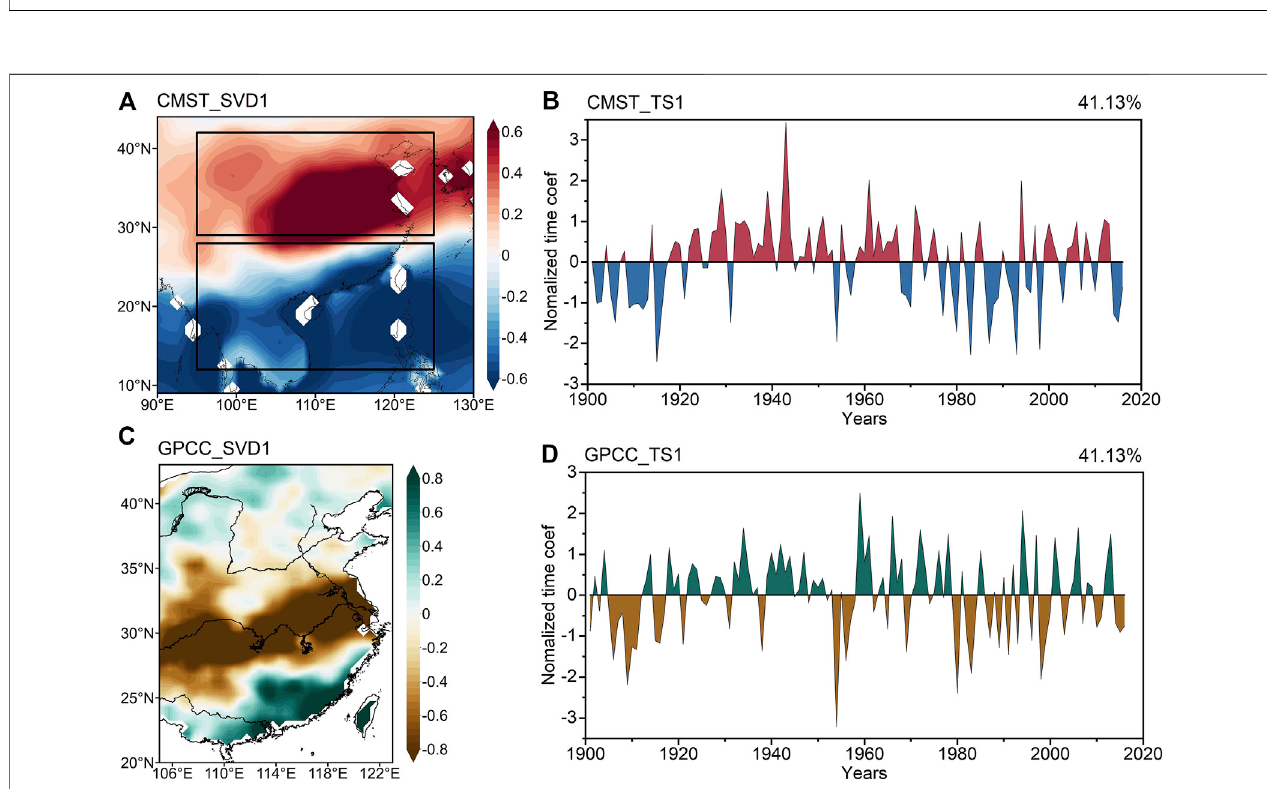
Frontiers in Environmental Science |